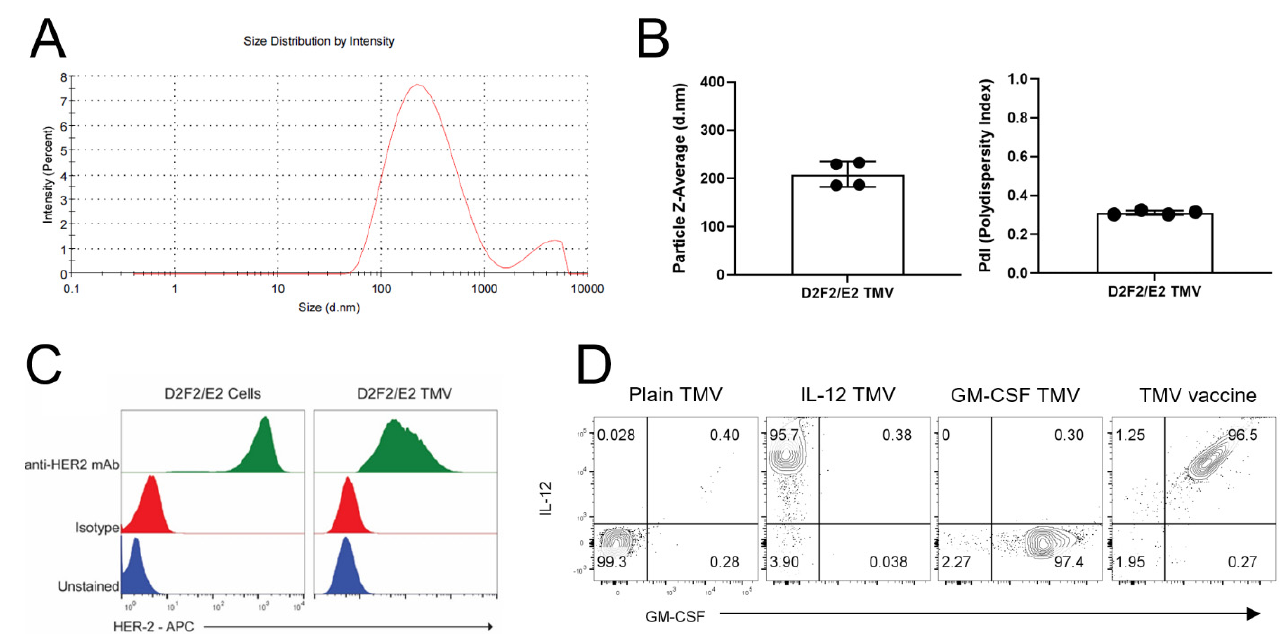
Figure 1. Tumor membrane vesicles vaccine characterization and GPI-ISM incorporation. ( A ), Zetasizer size distribution of TMVs prepared from D2F2/E2 cells. ( B ), Particle Z-Average (left panel) and polydispersity index (right panel) of four runs of D2F2/E2 TMVs on the Zetasizer. Error bars represent SD. ( C ), Surface expression of HER2 antigen on D2F2/E2 cells (left panel) and TMVs prepared from D2F2/E2 cells (right panel). ( D ), Flow cytometry plots of IL-12 and GM-CSF on D2F2/E2 TMVs without GPI-ISMs (Plain TMV), with GPI-IL-12 (IL-12 TMV), GPI-GM-CSF (GM-CSF TMV) and both GPI-ISMs incorporated (TMV vaccine) by protein transfer.